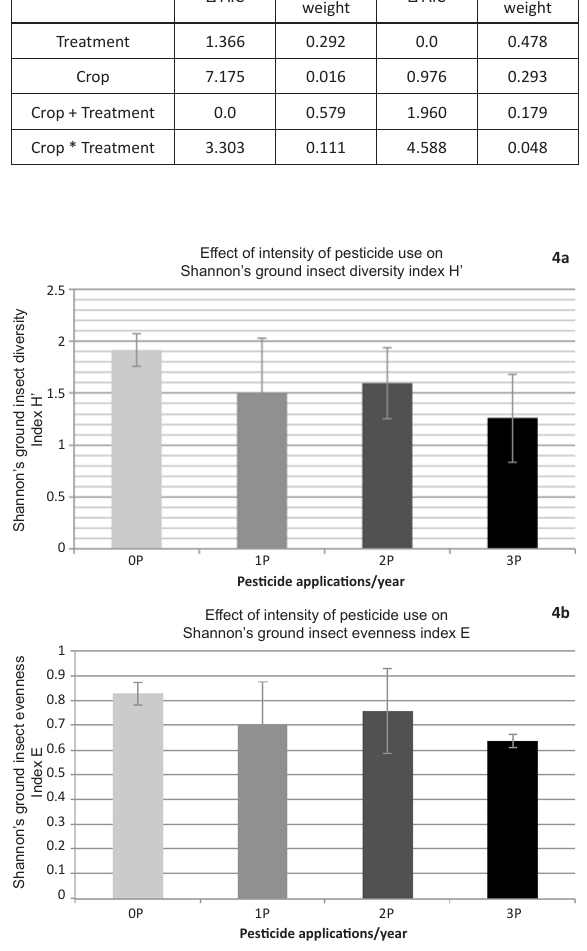
Figure 4. The bar graph shows the effect of increase in chemical pesticides on ground insect species diversity (Fig. 4a) and evenness (Fig. 4b) with their 95% confidence intervals (CI).